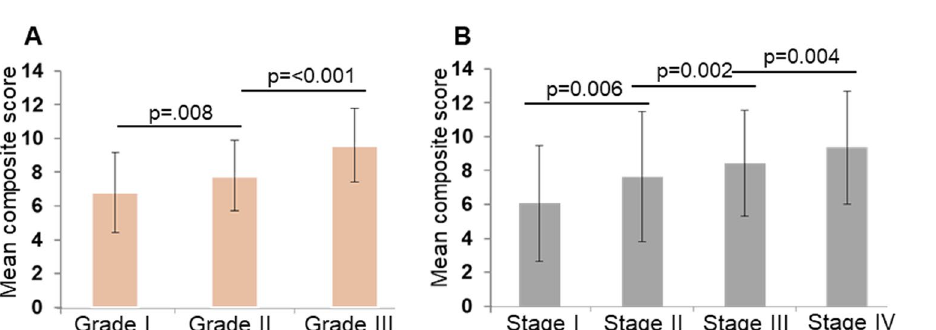
Figure 2. MYB expression in OC tissues of different histological grades and clinical stages. MYB protein expression levels (composite scores) in OC cases belonging to histological grades I, II, and III ( A ) and clinical stages I, II, III, and IV ( B ) were used to establish a statistically significant association. A p value of < 0.05 was considered